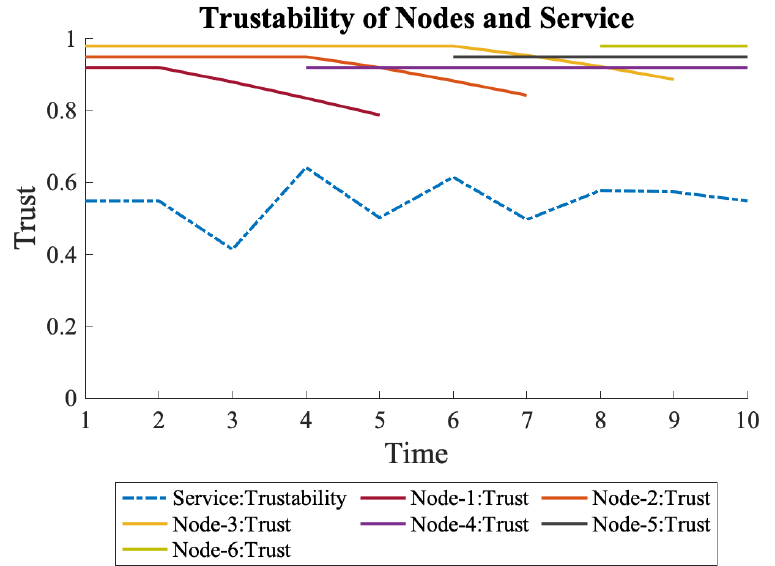
Figure 16. Deactivating a node that is losing trust is one way to keep costs low with the least sacrifice in the overall trustability of the